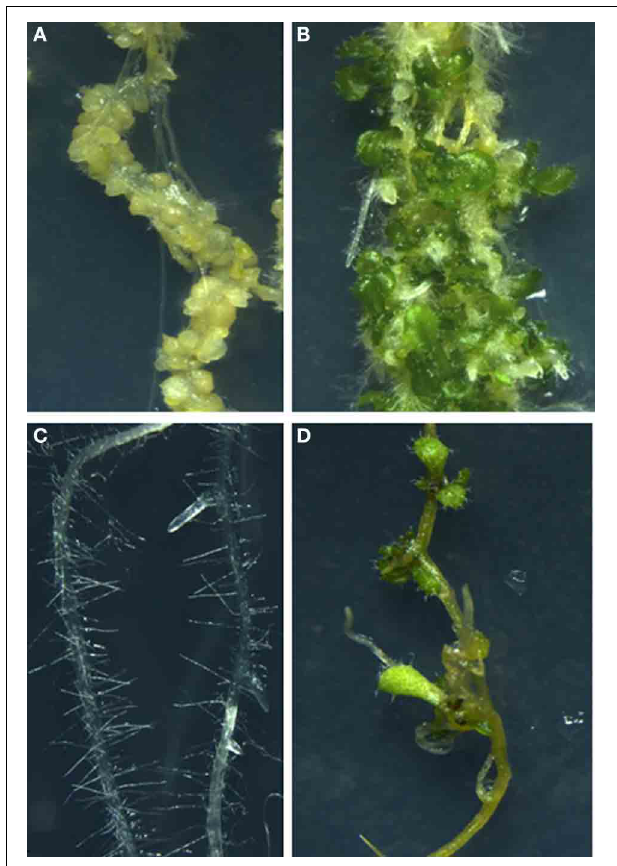
FIGURE 5 | Direct and Indirect de novo organogenesis. Callus formation from Arabidopsis root explant on auxin rich callus inducing medium (CIM) (A) . De novo shoot regeneration on callus incubated on cytokinin rich shoot inducing medium (SIM) (B) . Arabidopsis root explant with lateral root primordia from where lateral root emerges out incubated on normal MS medium (C) . Direct shoot regeneration from lateral root primordia of Arabidopsis root upon incubation on cytokinin rich medium (D)